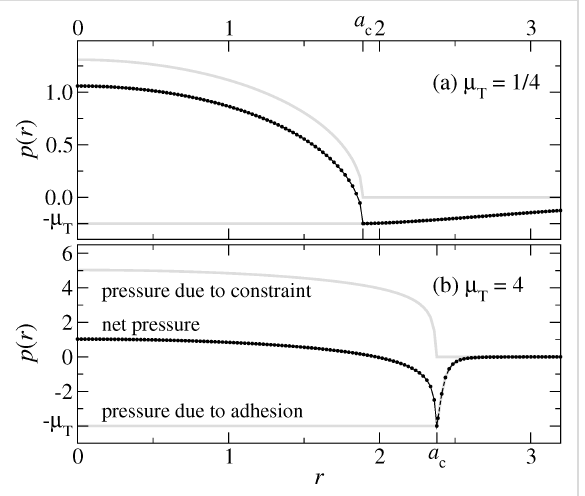
Figure 5: Interfacial pressure on a free, linearly-elastic half space resting at zero external load on a rigid, adhering, parabolic substrate for (a) μ T = 1/4 and (b) μ T = 4 in case of the exponential model. In each case, the upper and lower grey lines indicate, respectively, the pressure due to the constraint and that due to adhesion. Contact radii are indicated by a c . The net pressure is shown by a black line as well as by small circles representing the actual grid points. Units are chosen according to Equation 23–Equation 26.